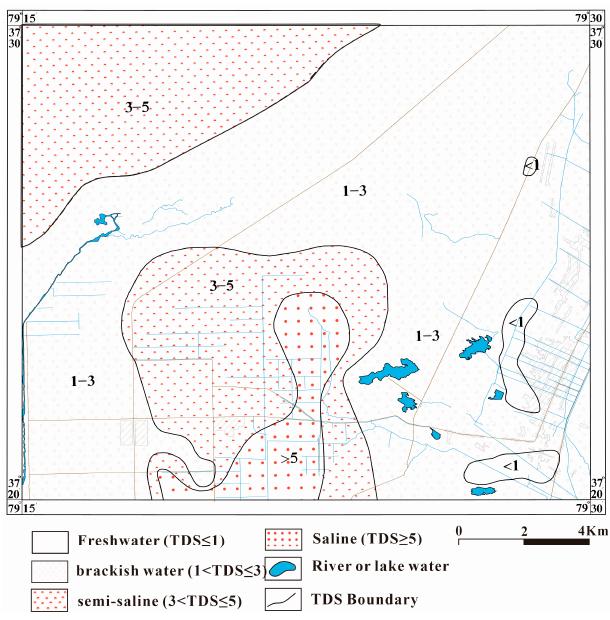
Figure 3. Distribution map of groundwater TDS value.